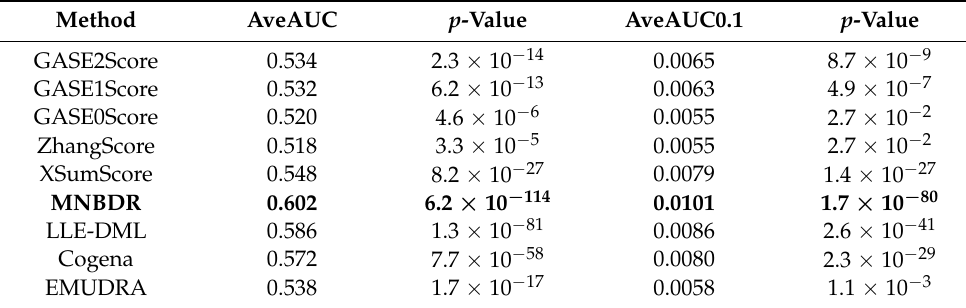
Table 2. Comparison results of all methods on the 19 cancer